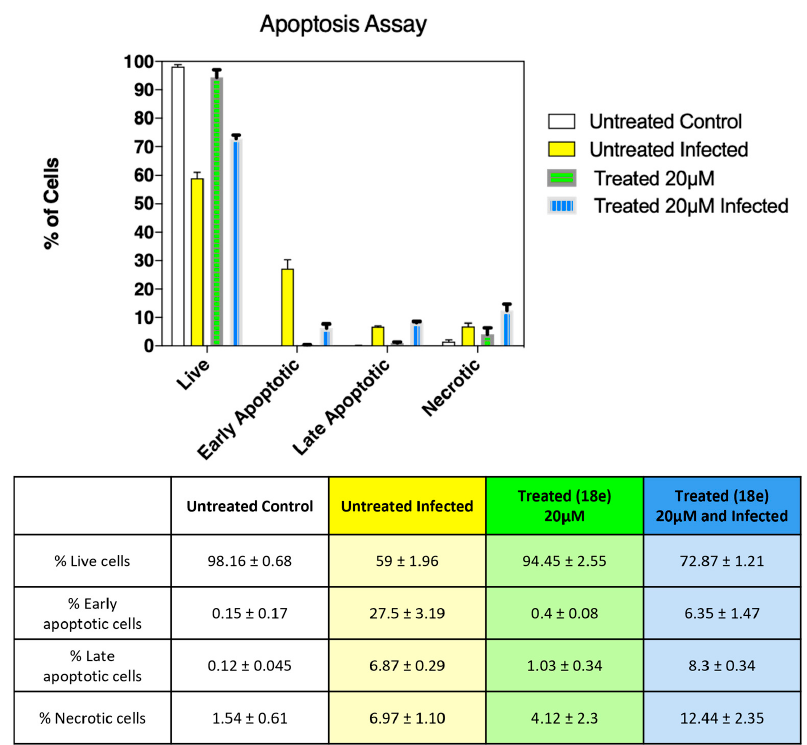
Figure 7. Derivative 18e protected Vero 76 cells from apoptosis induced by CVB5 infection. The percentage of live, apoptotic, and necrotic cells were measured by flow cytometry using the PI- annexin V assay. The graph shows the percentage of live, apoptotic, and necrotic cells. Each value represents the mean ± SD of independent experiments ( n = 3).